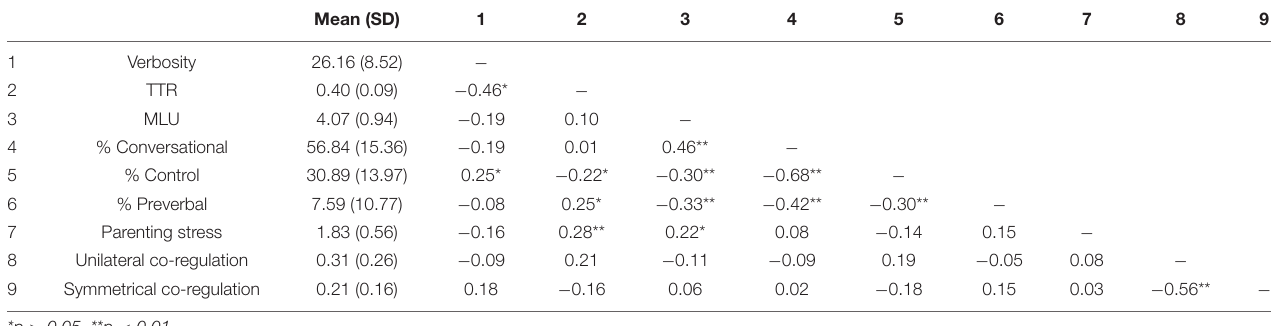
TABLE 1 | Descriptive and bivariate correlations for the full sample.